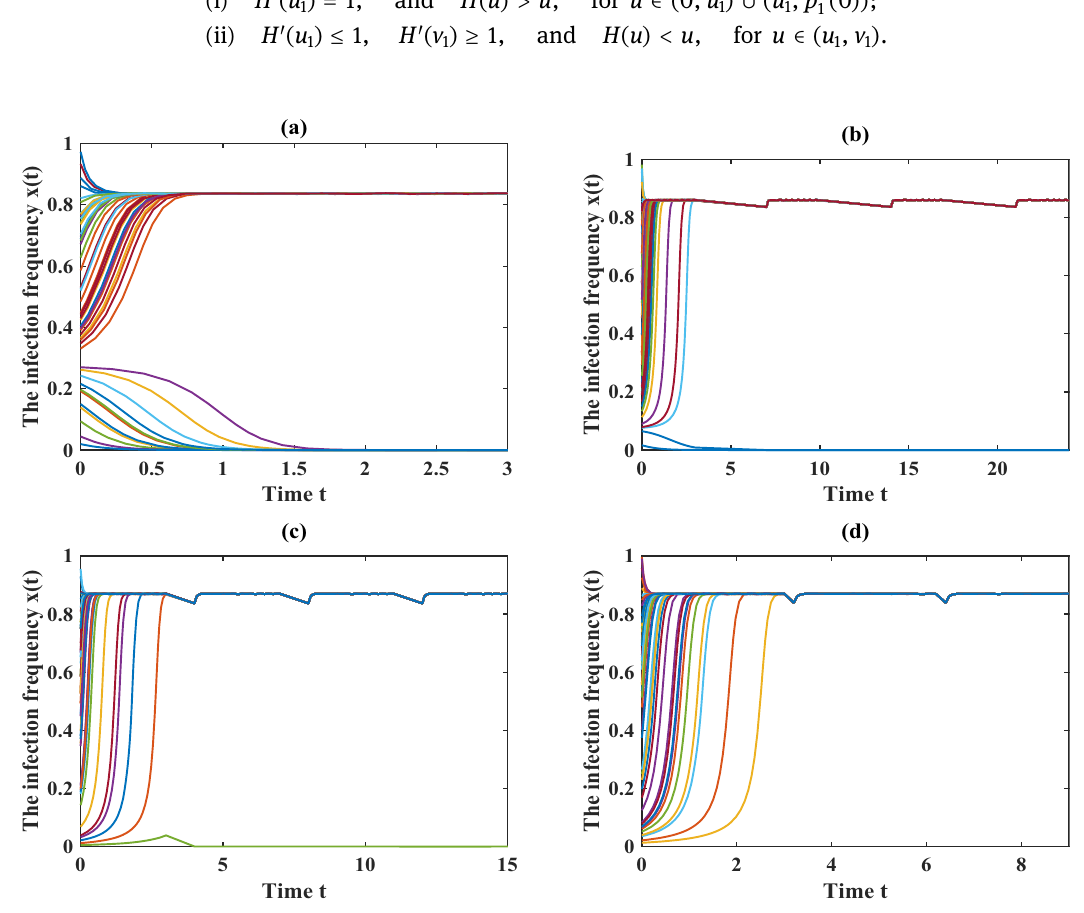
Figure 2: Given = μ 0.1